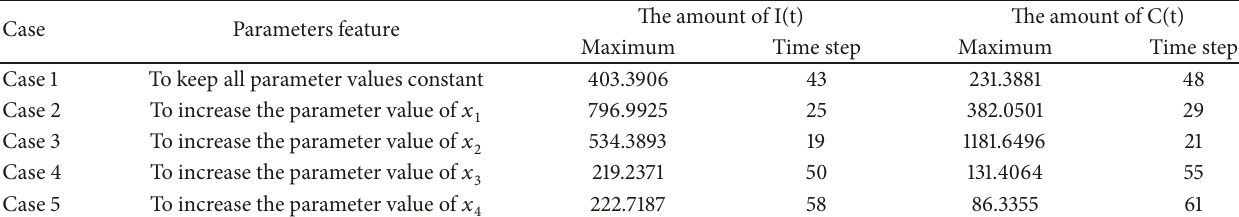
Table 3: The maximum of infected agents and contagious agents in simulation